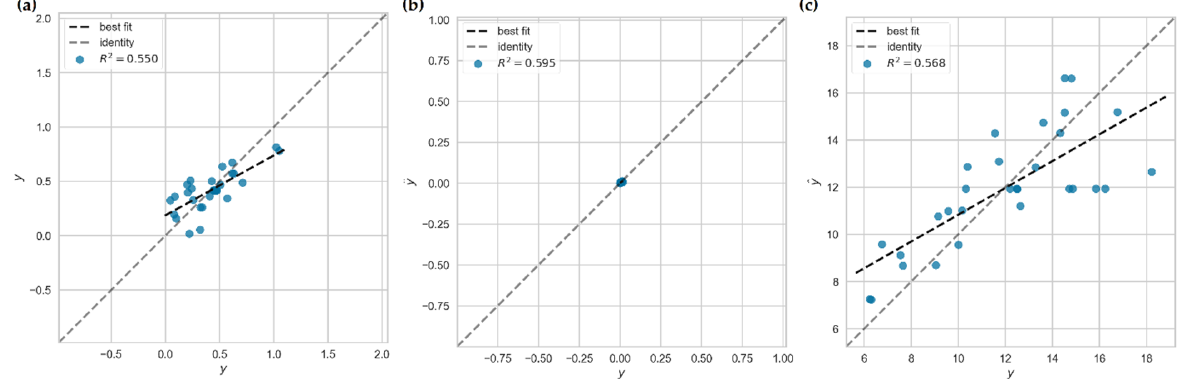
Figure 2. Experimental versus linear regression predicted ( a ) MRR ( b ) EWR ( c ) SR.